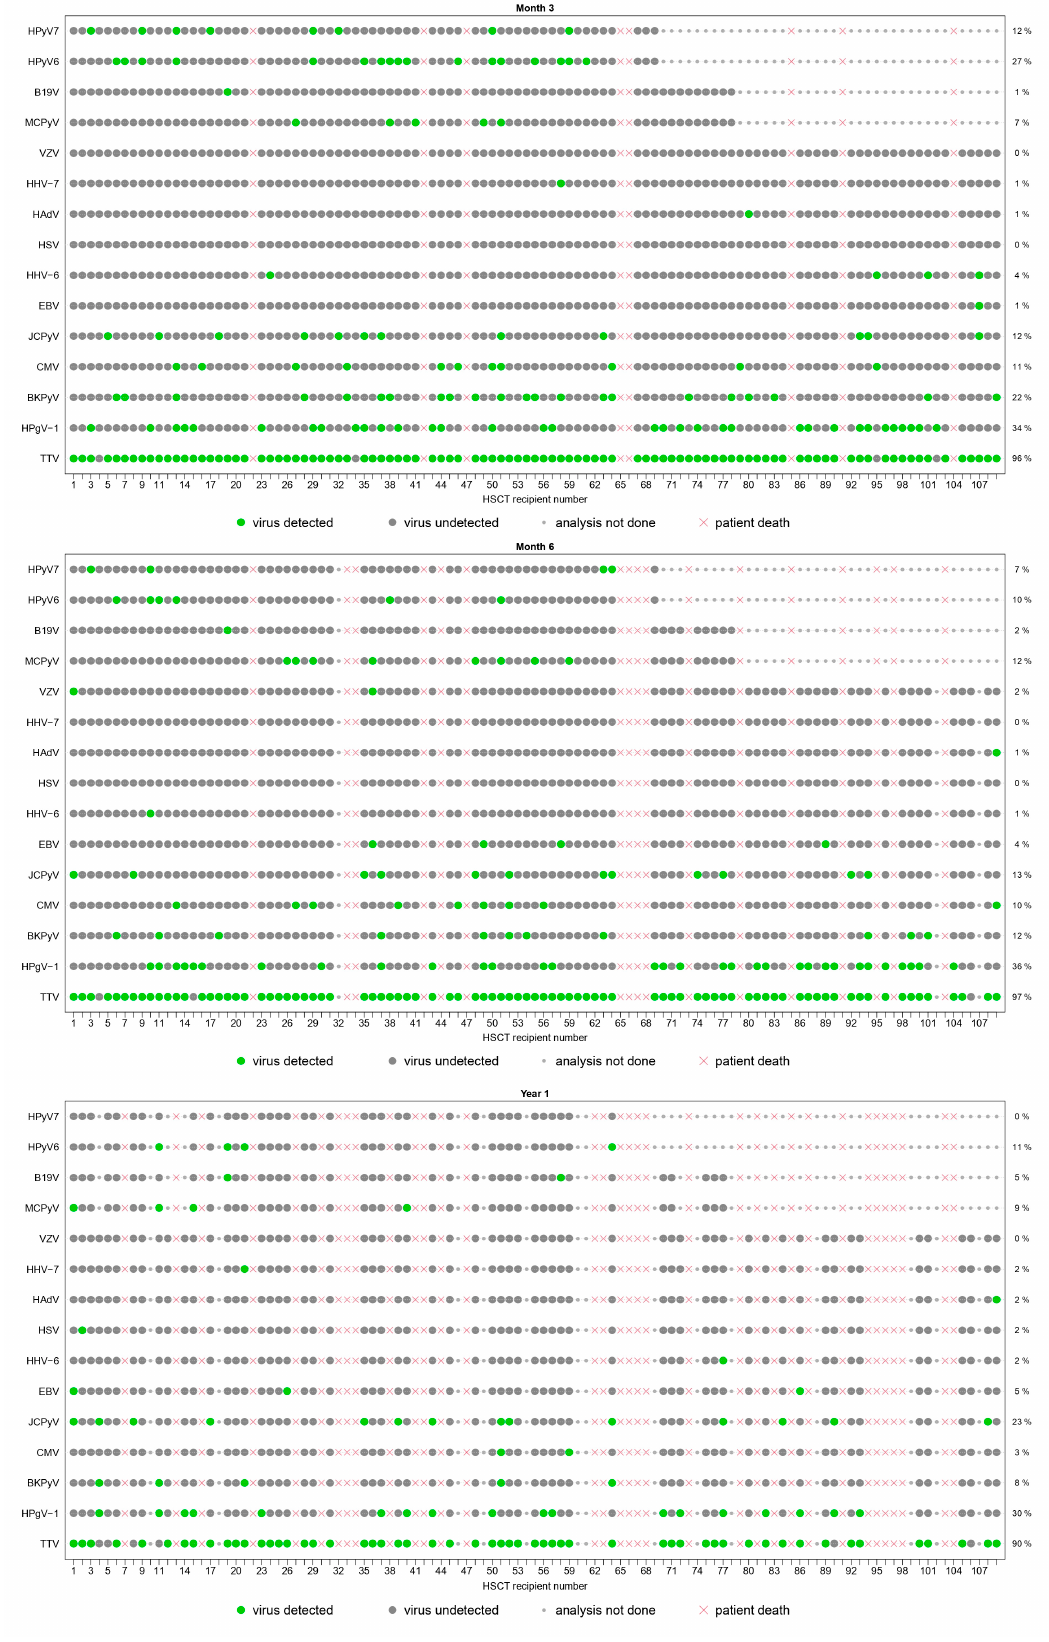
Figure 3. Schematic representation of the plasma detection of viral species screened from D0 to